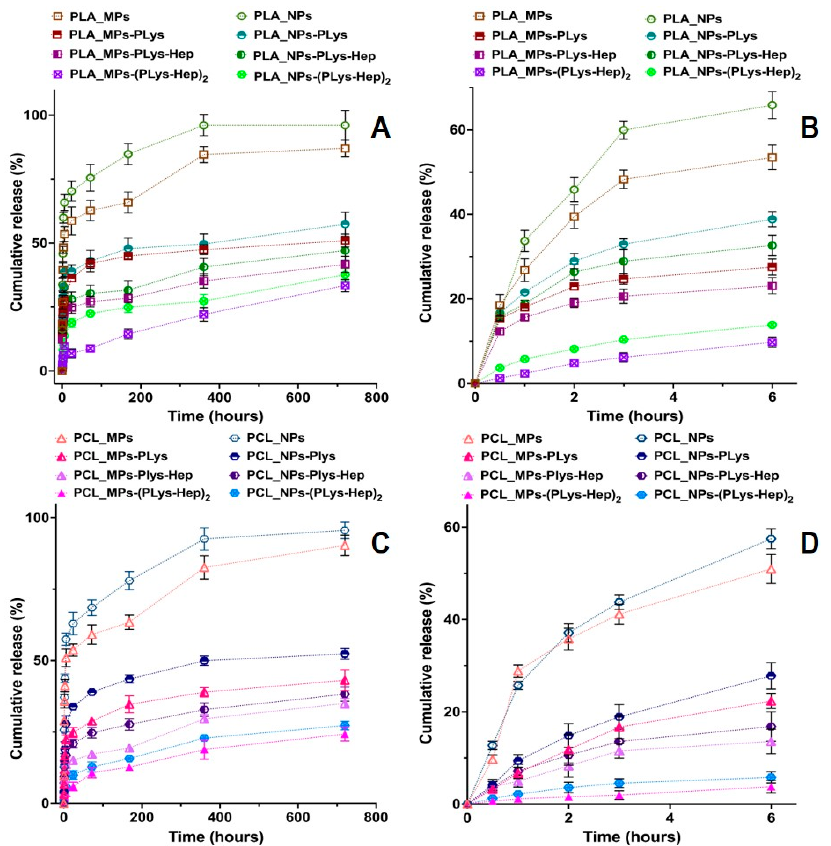
Figure 3. Kinetic curves of prednisolone release from the non-modified and modified particles based on PLA ( A , B ) and PCL ( C , D ) particles during 720 h ( A , C ) and 6 h ( B , D ). Conditions: 0.01 M phosphate-buffered saline (PBS), pH 7.4, containing 0.1% of SDS. Fitting of prednisolone release data are presented in Supplementary Materials.